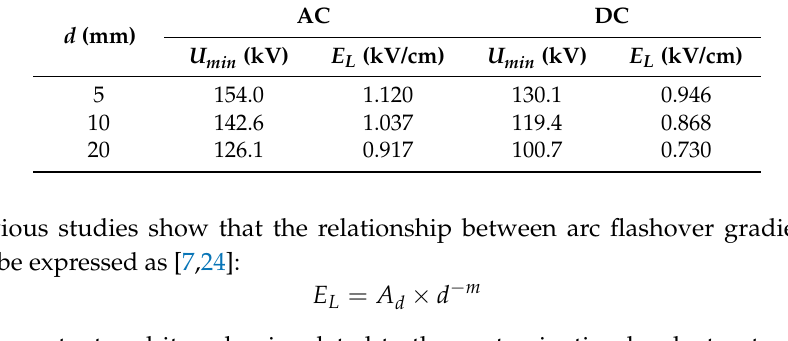
Table 6. AC and DC arc flashover gradients of snow-covered insulators under different d . AC d (mm)